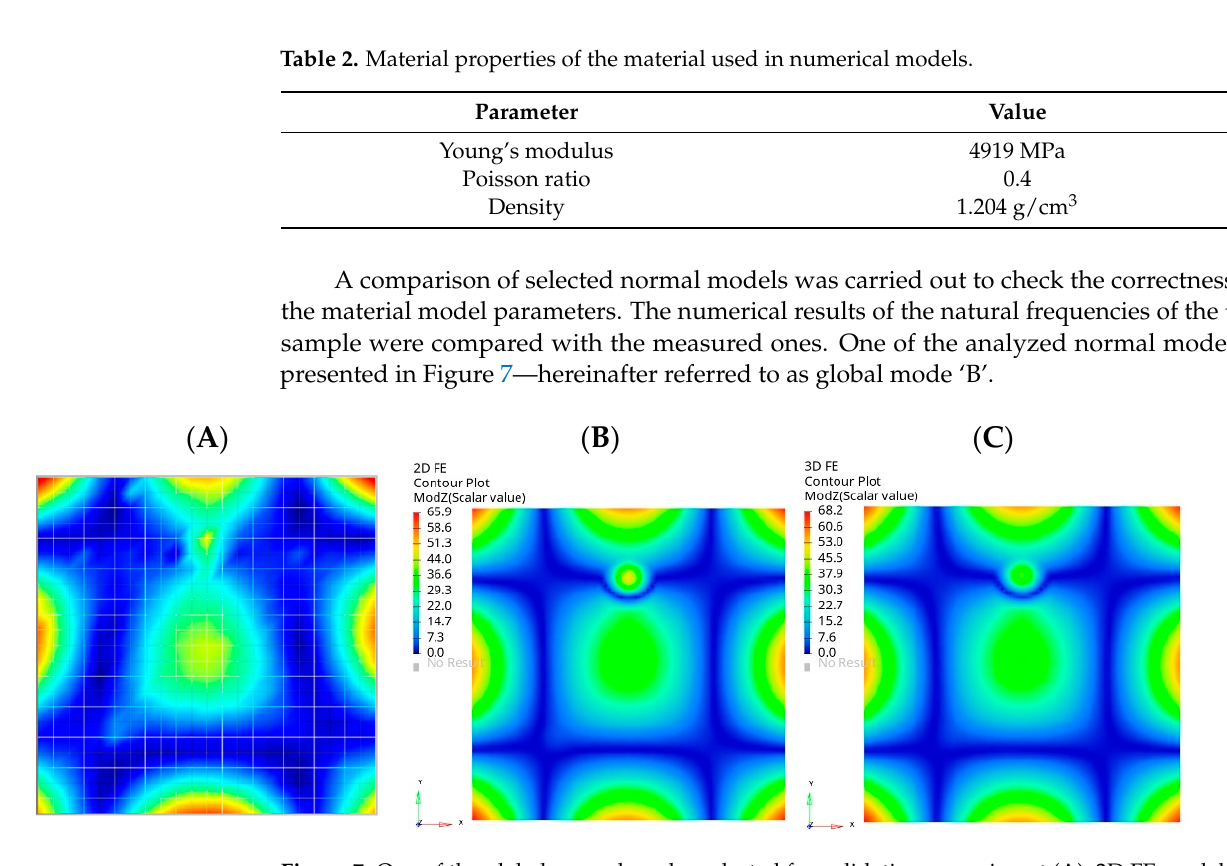
Figure 7. One of the global normal modes selected for validation: experiment ( A ), 2D FE model ( B ), 3D FE model ( C ).